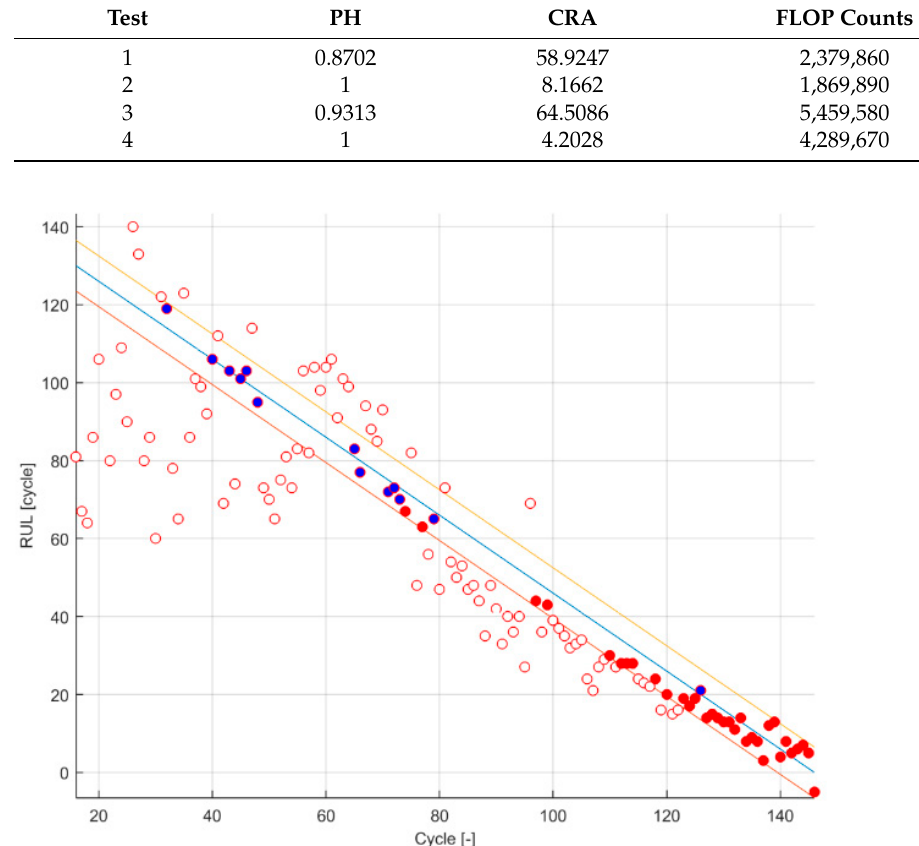
Figure 6. Results from test nº 2 (“B0018” linearly modelled).